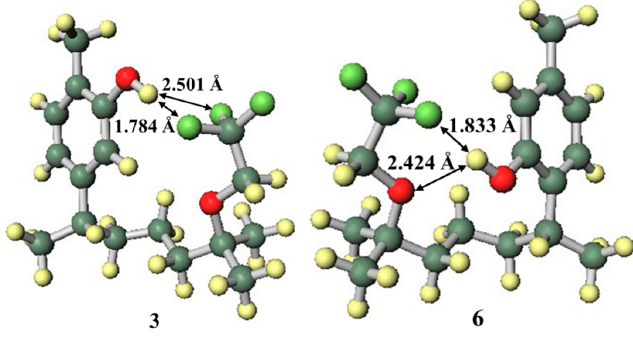
Figure 6. Structures of the radical cations of compounds 3 and 6 .